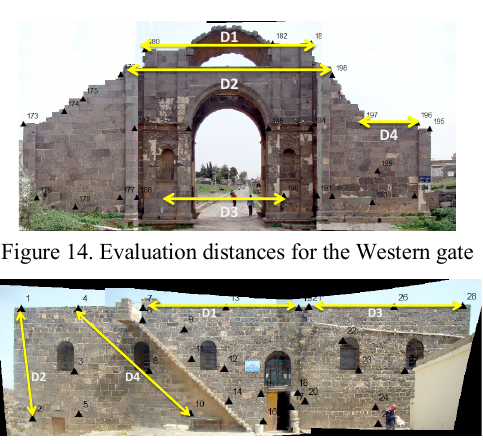
Figure 15. Evaluation distances for Al Omari